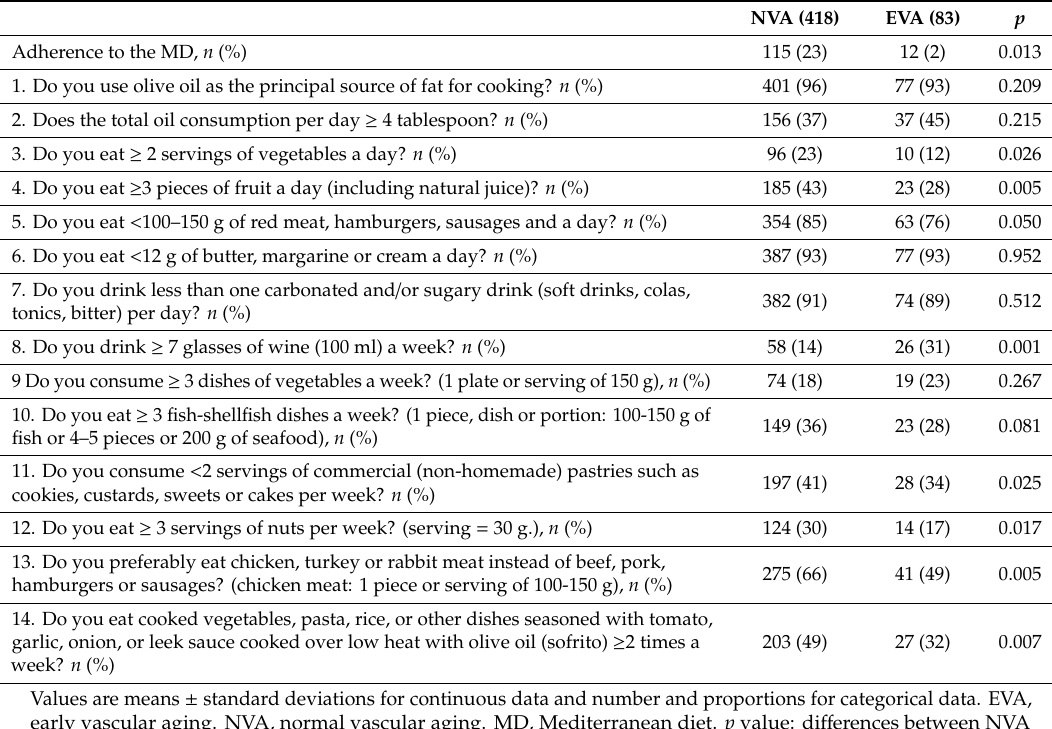
Table 2. Components of Mediterranean diet adherence by vascular